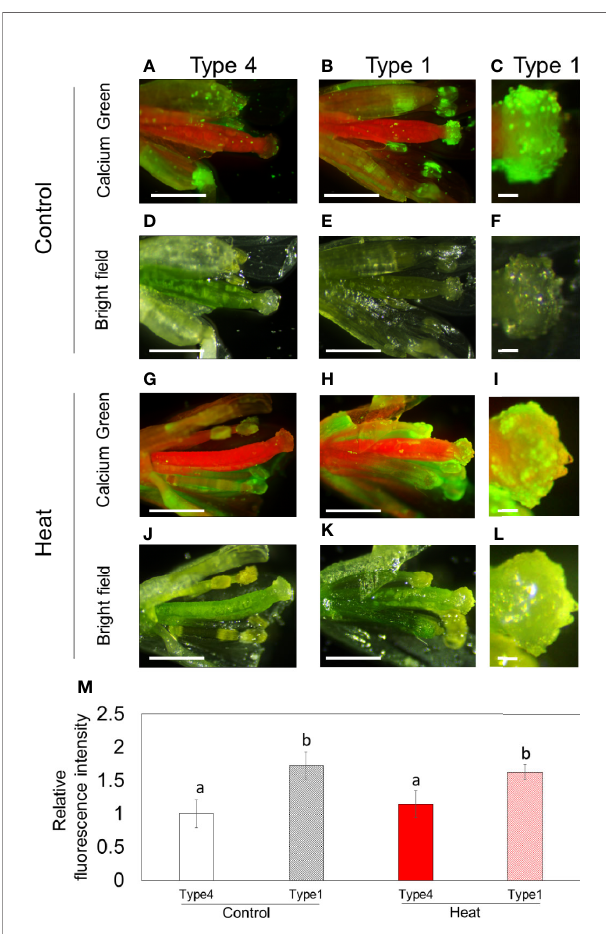
FIGURE 5 | Distribution of Ca 2+ in reproductive organs of Arabidopsis plants (Columbia-0) grown under control conditions or subjected to heat stress. (A – L) Calcium green staining of reproductive organs in fl owers with rich (type 1) or poor (type 4) pollen attachment under control (A – F) or heat stressed (G – L) conditions. (C, F, I, L) Enlarged fi gures of stigma in (B, E, H, K) , respectively. (D – F, J – L) Bright fi eld images. Scale bars in (A, B, D, E, G, H, J, K) indicate 1mm, and scale bars in (C, F, I, L) indicates 100 m m. (M) Relative fl uorescence intensity of Ca 2+ level in stigma. Bars indicate standard error. Two-way ANOVA followed by Tukey's test was performed (n=5). Values statistically different at P<0.05 are denoted with different letters (a and b).